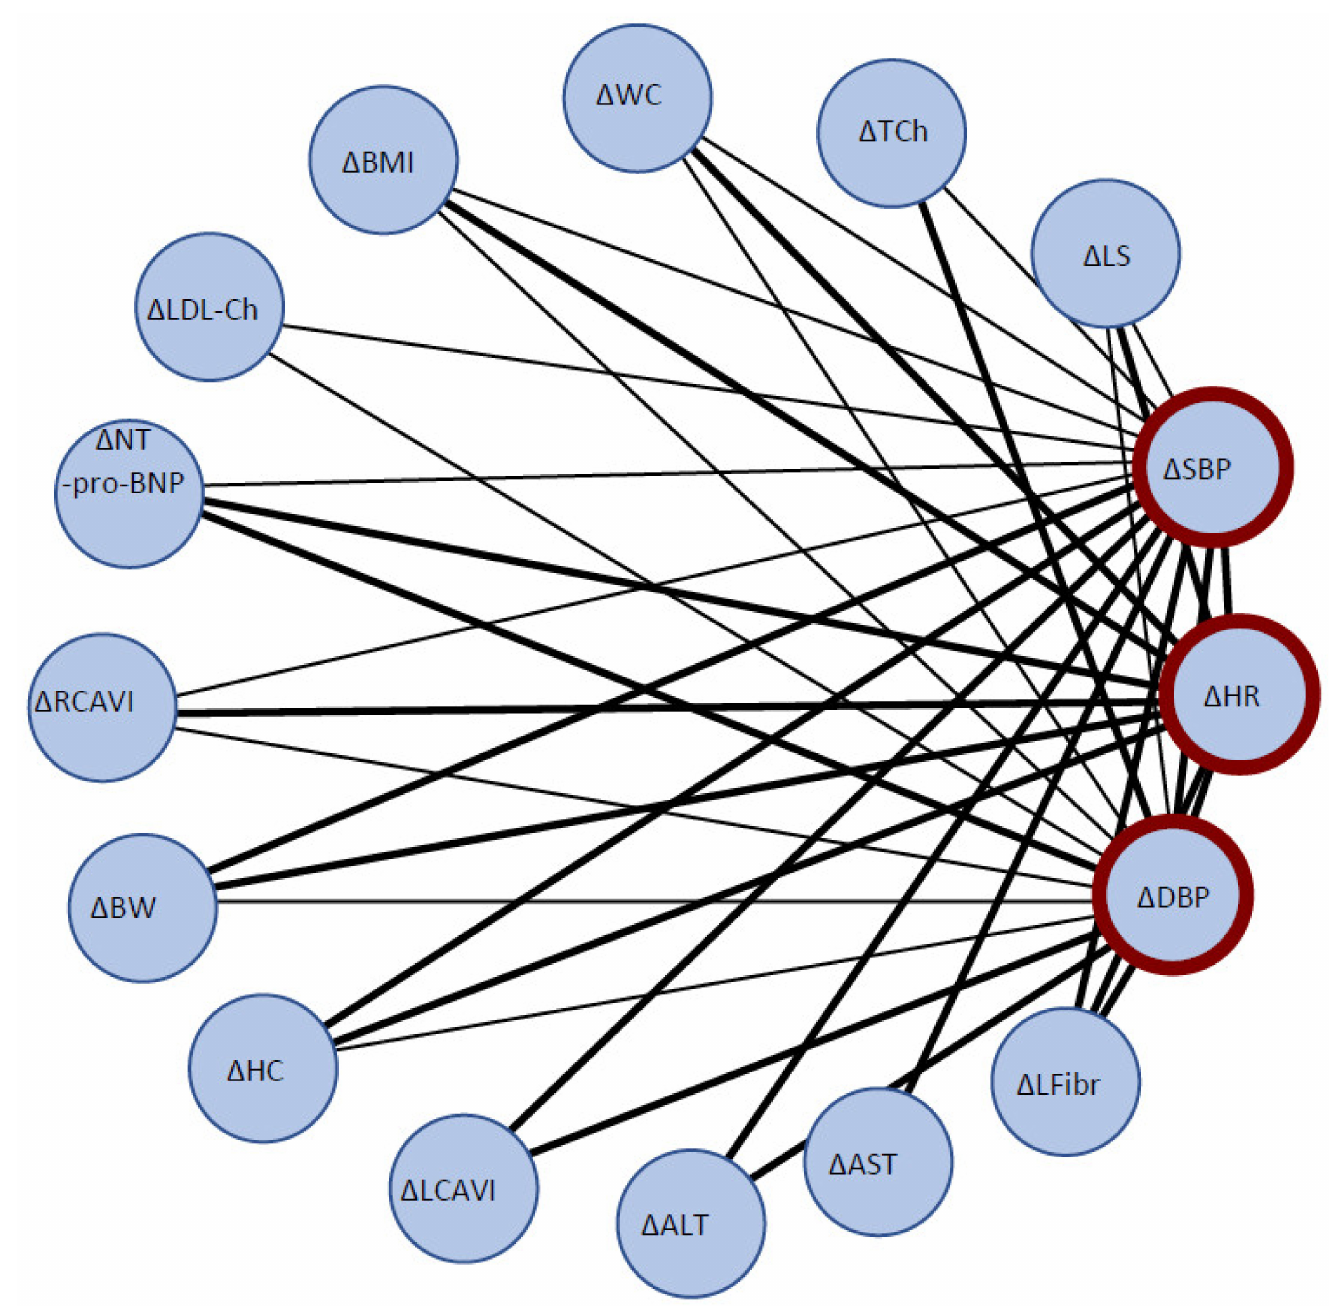
Figure 2. Correlation analysis between pre-post deltas of key hemodynamic parameters (SBP, DBP, and HR) and other variables. Thick lines—strong correlations (r ≥ 0.60), thin lines—moderate correlations (r ≥ 0.40). SBP—systolic blood pressure, DBP—diastolic blood pressure, HR—heart